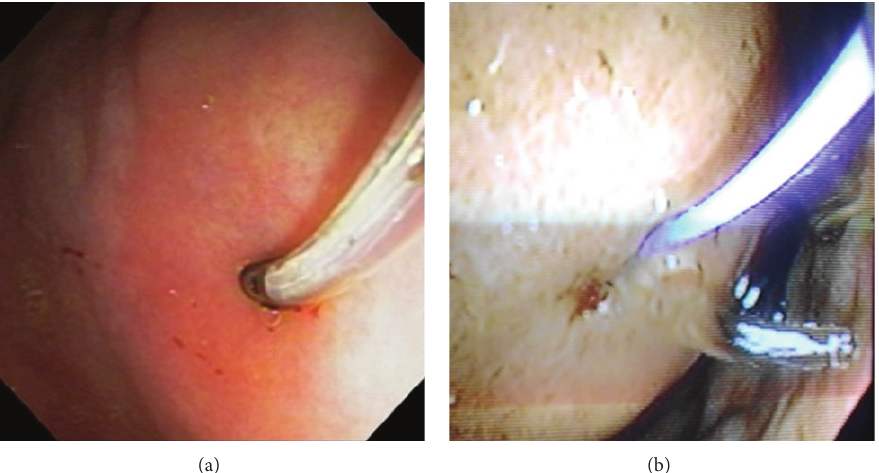
Figure 3: (a) A needle knife papillotome punctures the most protuberant point on the gastric mucosa; (b) entry into the cyst confirmed by a gush of clear fluid returning.